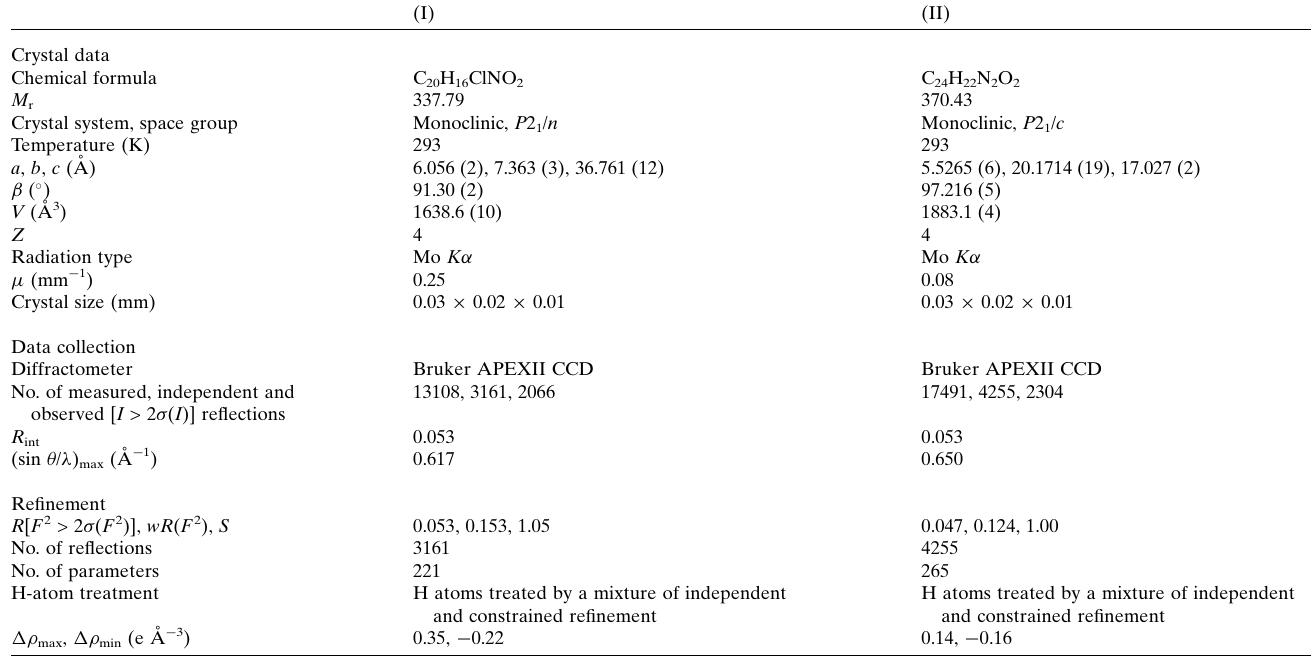
Table 4 Experimental